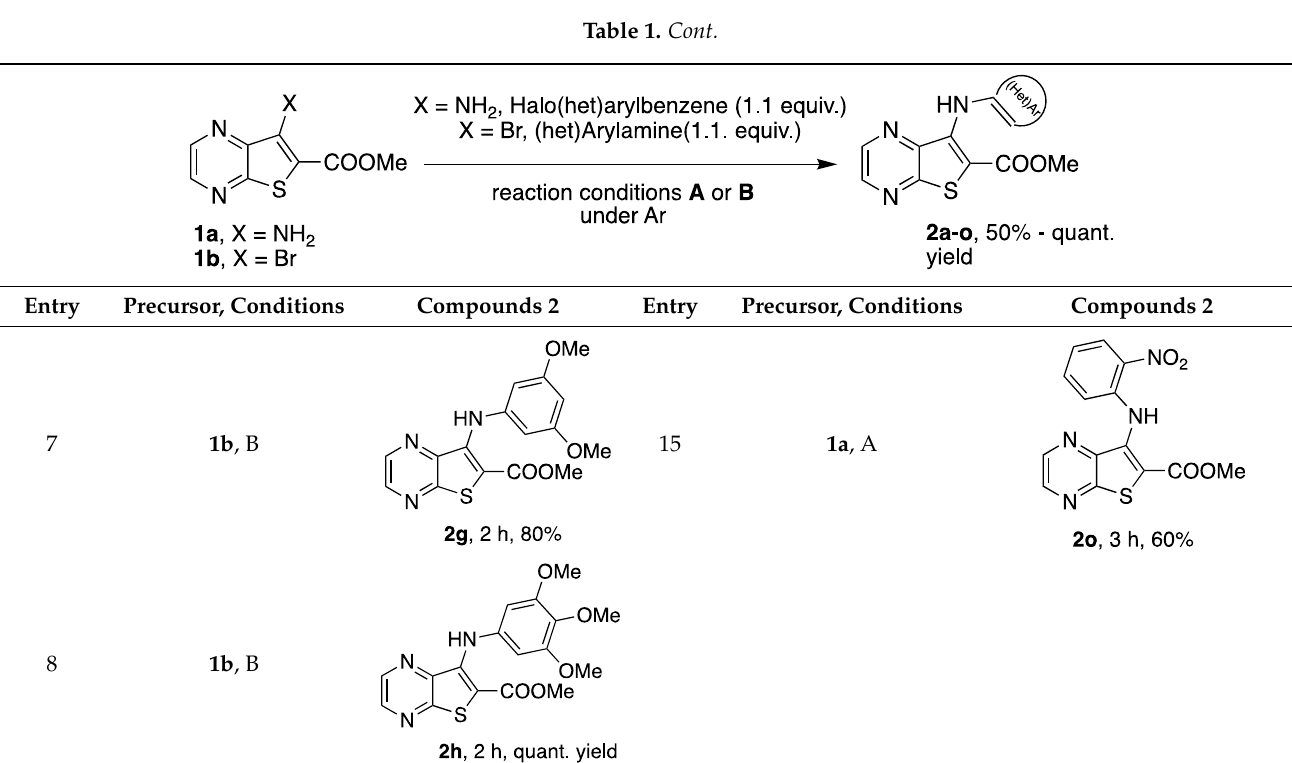
Table 1. Cont. Table 1. Synthesis of di(hetero)arylamines 2a – 2o by C–N Buchwald–Hartwig cross-coupling.